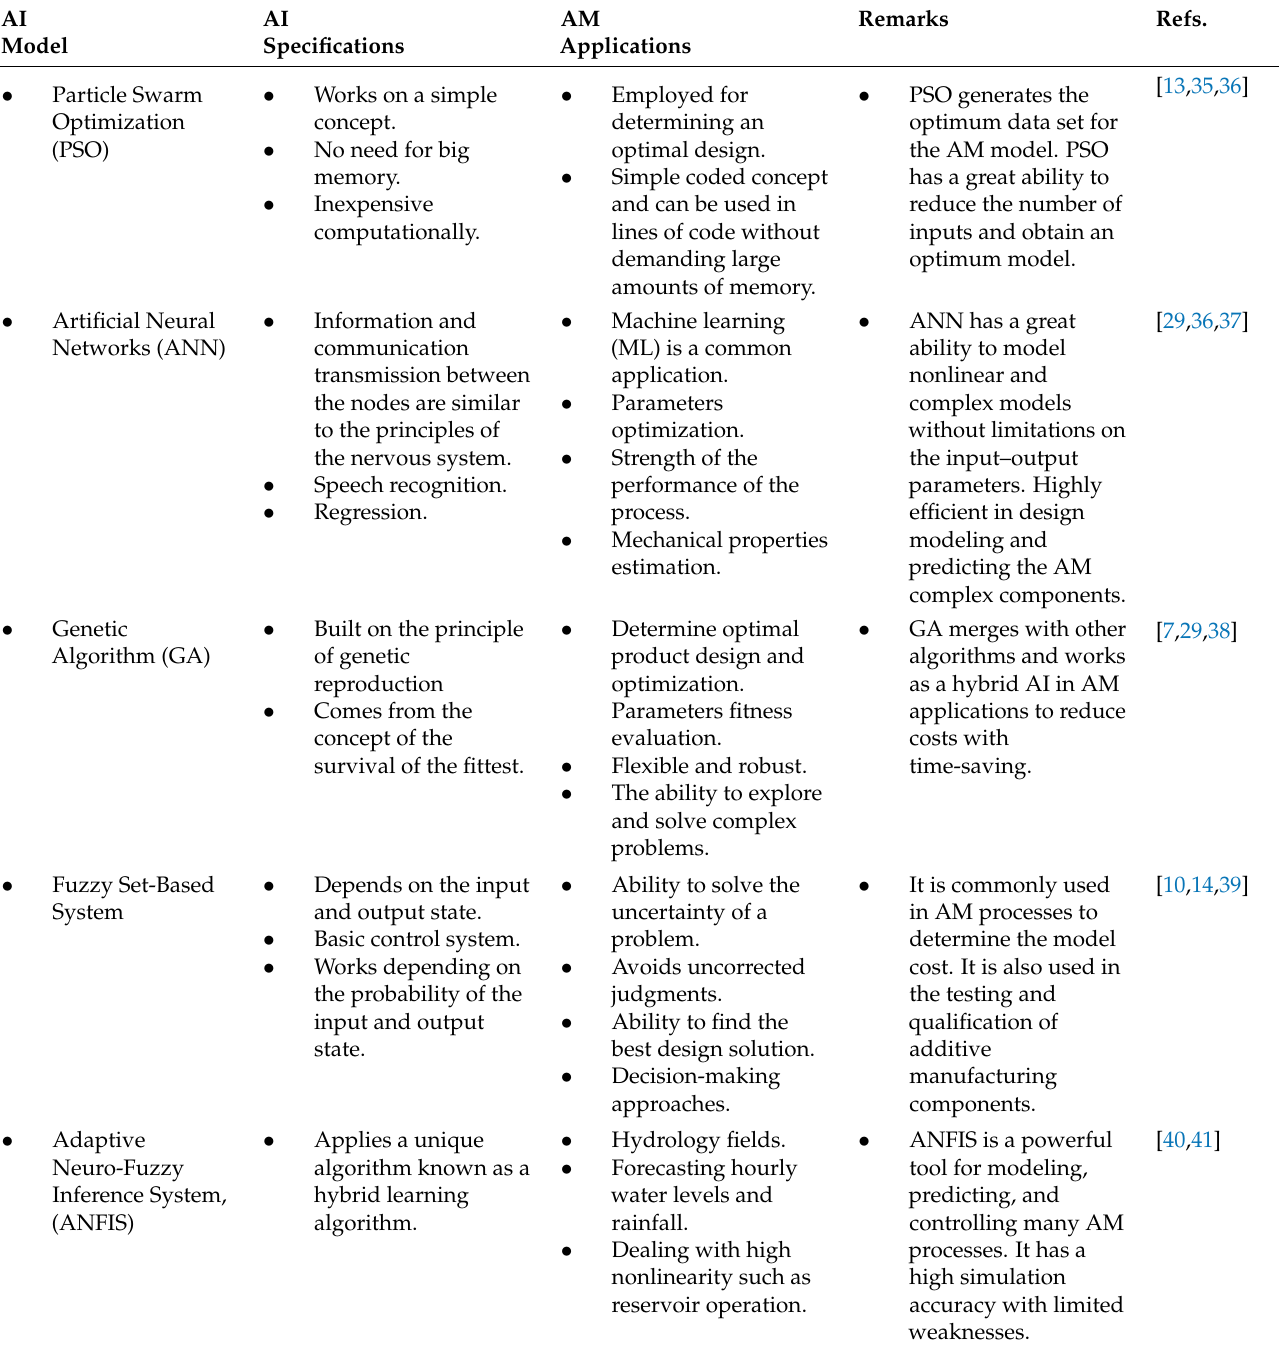
Table 1. The important types of AI that are used in AM